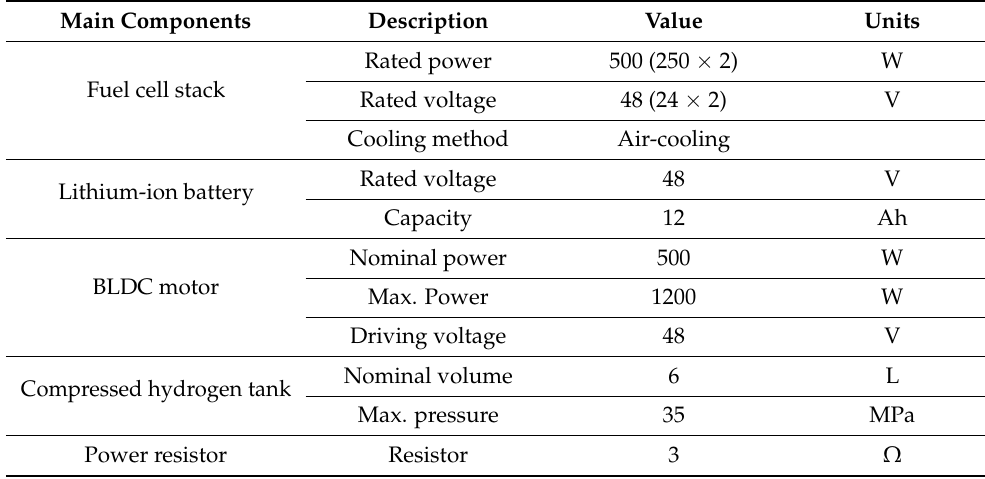
Table 1. Specifications for the major components in the passive hybrid system for scooters. Main